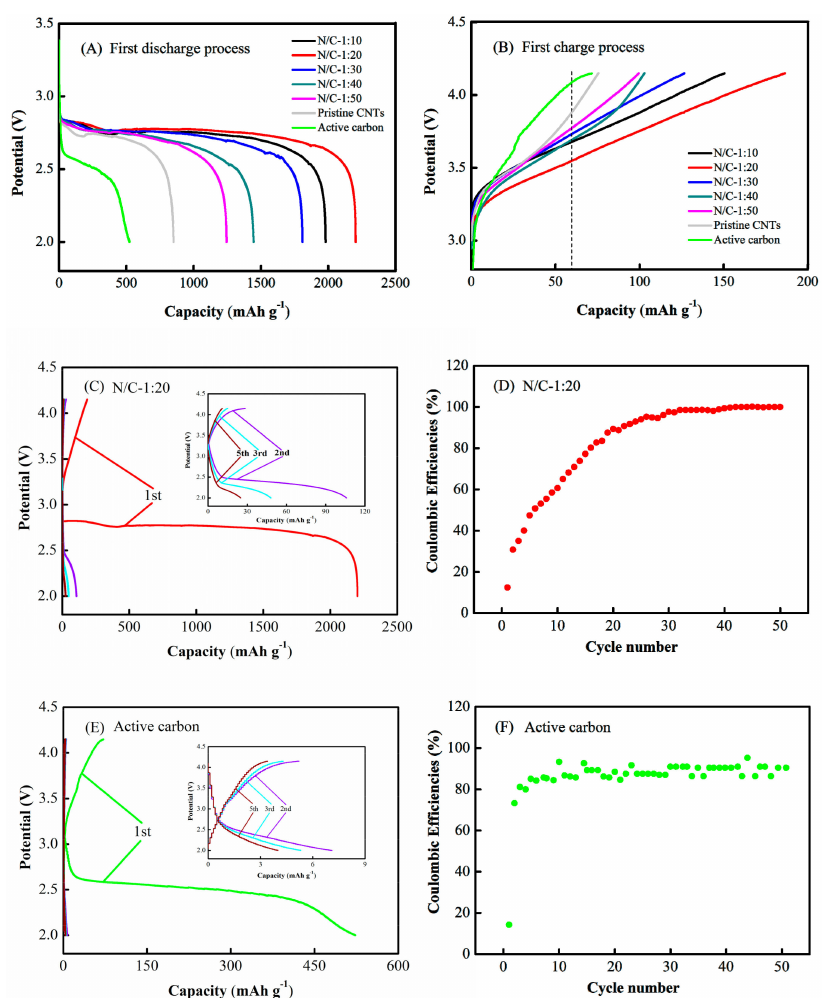
Figure 6. ( A ) First discharge and ( B ) first charge curves of Li–air batteries with N-CNT arrays, pristine CNT arrays, and active carbon as the air electrode, respectively. Discharge–charge curves and Coulombic e ffi ciencies of Li–air batteries of ( C , D ) the N-CNT arrays with N / C feed ratio of 1:20 and ( E , F ) the active carbon as the air electrode at a current density of 0.05 mA cm − 2